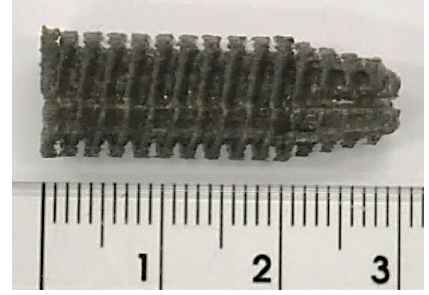
Figure 7. ACL screw from PLA-Mg-vitamin E (Composition 1).